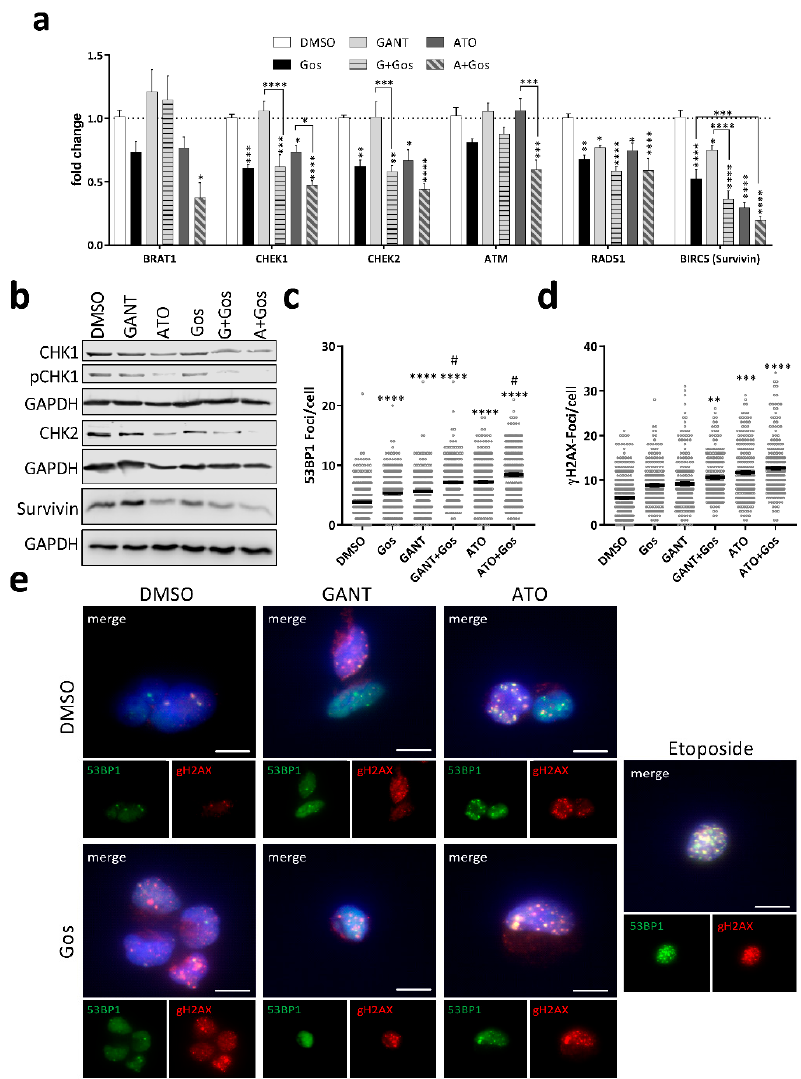
Figure 4. GANT or ATO in combination with Gos synergistically induces DNA damage in GSC